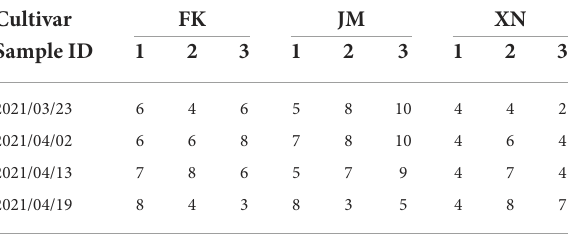
TABLE 1 Tiller numbers of each sampled wheat shoot in four growth stages. Each cultivar involves three sample replicates. Cultivar FK JM